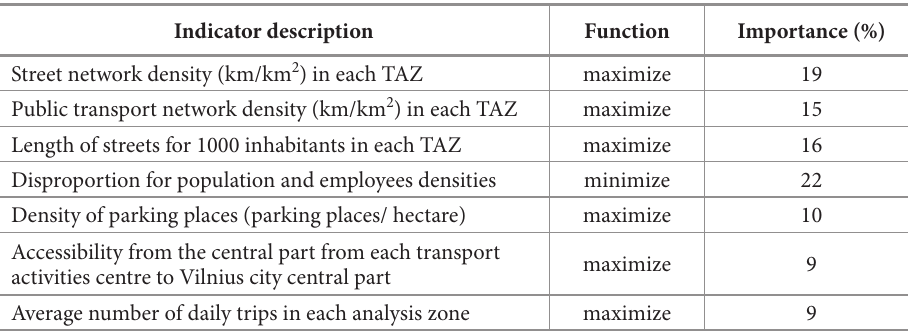
table 2. Transport system indicators for Vilnius TAZ analysis Indicator description function Importance